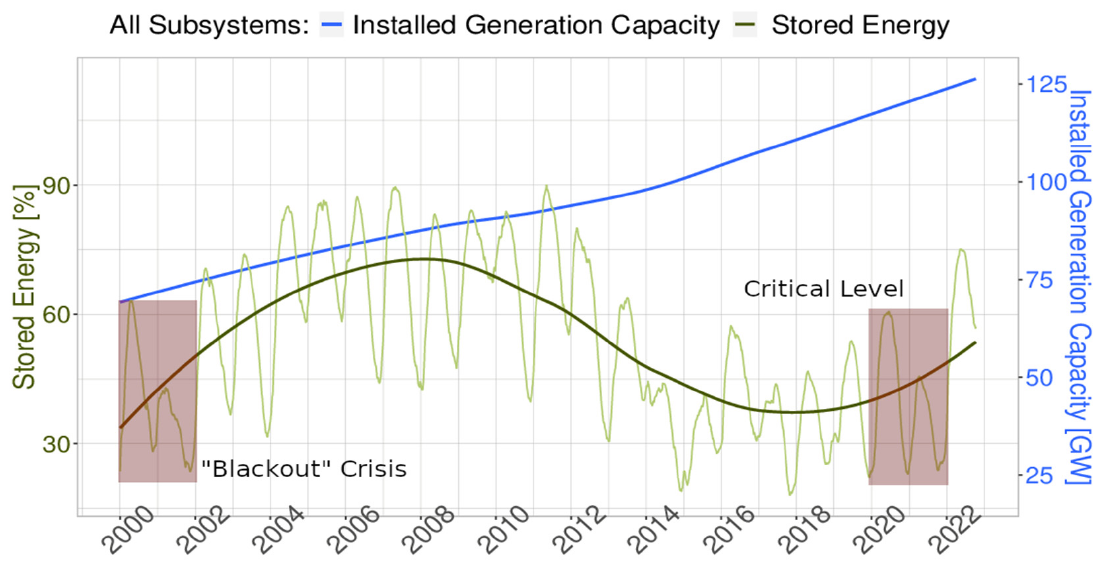
Figure 2. Stored Energy data (SED) × Installed Generation Capacity (GW)—Compiled Historical Series.